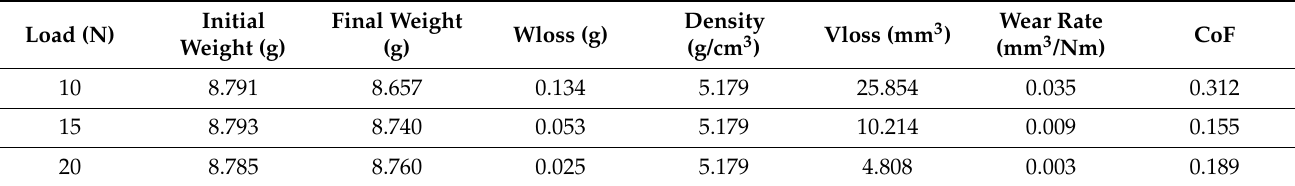
Table 2. Volume loss (V loss ), wear rate, and CoF of